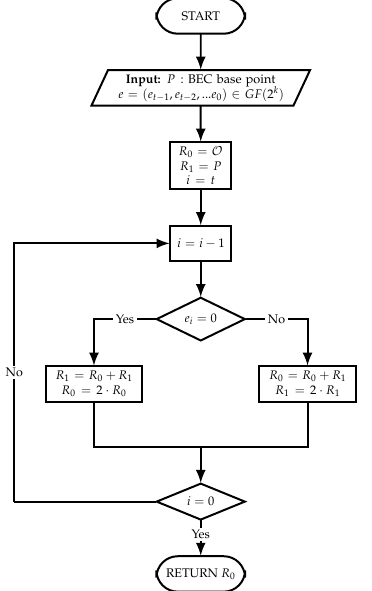
Figure 1. Control flow graph for MPL